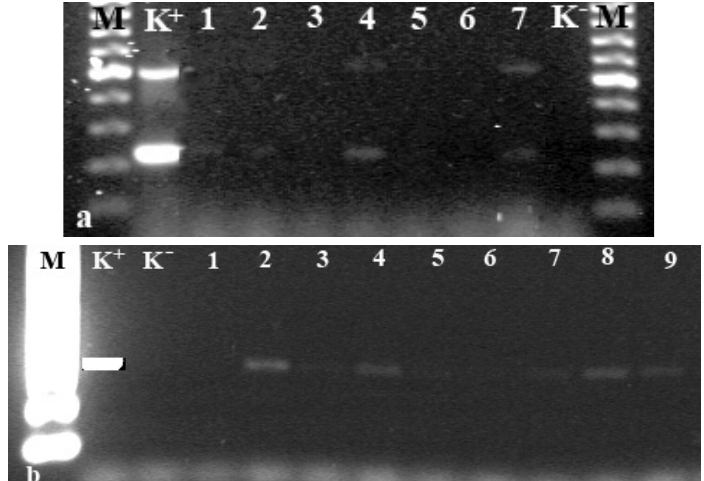
Figure 2. Gel electrophoresis analysis of polymerase chain reaction products amplified by duplex-PCR (a) and RG- PCR (b) performed on individual cones of the columellae of fruits. K + , bacterial suspension (10 8 cfu mL -1 ) of Pseudomo- nas syringae pv. actinidiae CRA-PAV 1530; M, molecular marker (100 pb DNA Ladder Plus; Fermentas, Lithuania); K - , negative control (water).